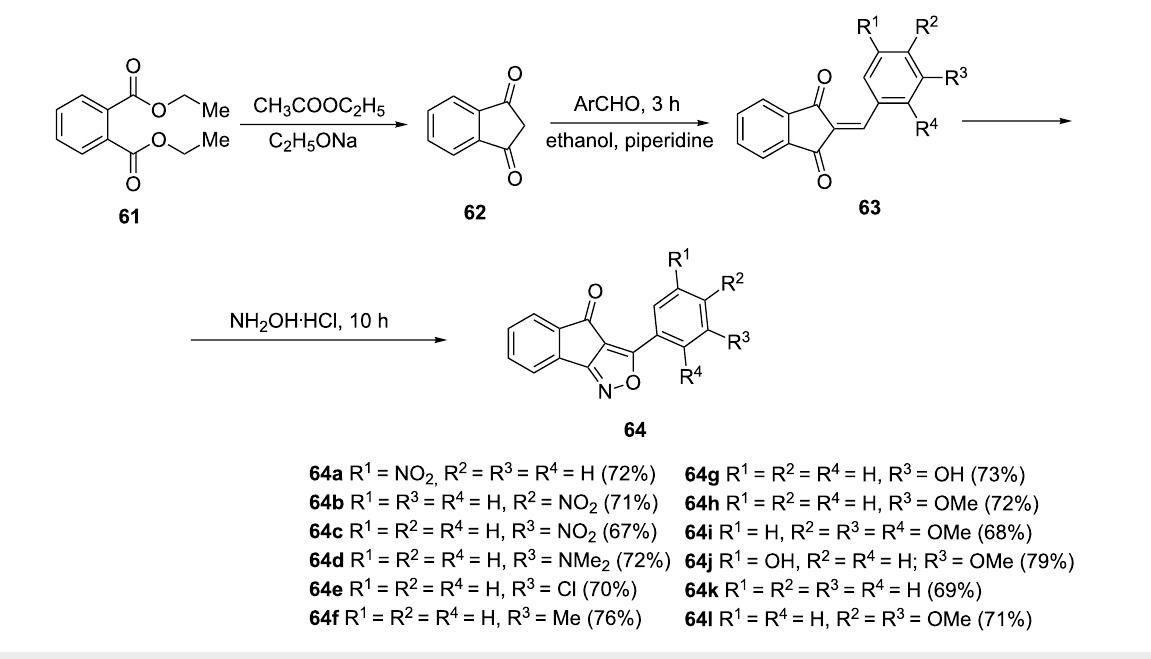
pared with standard indomethacin (a non-steroidal